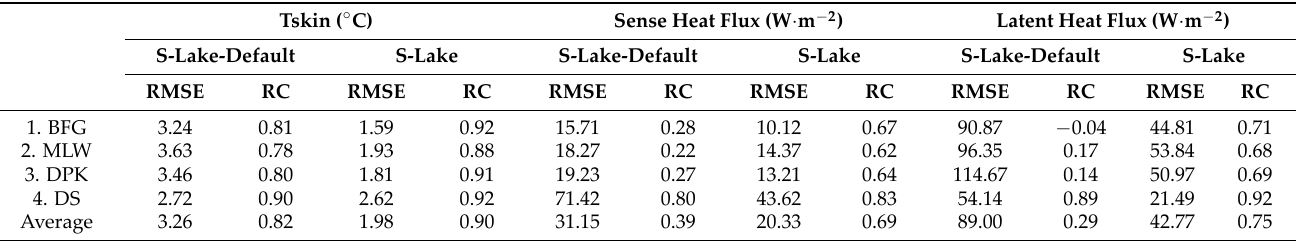
Table 2. Statistical indices (RMSE and RC) associated with hourly variables provided by the meteo‑ rological sites ( ☆ ) in Figure 1. Observed and modeled wind speed and 2 m air temperature from the nearest grid point from 1 June to 31 August 2012. Tskin ( ◦ C) Sense Heat Flux (W · m − 2